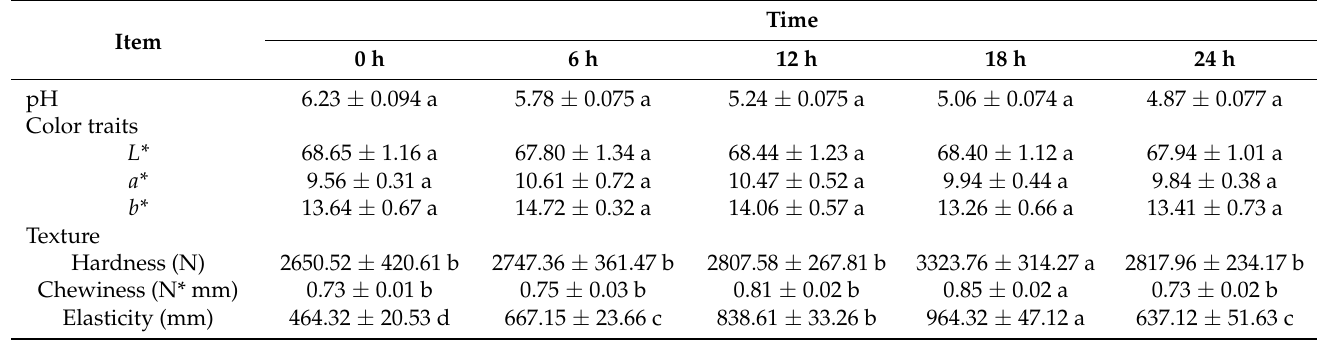
Table 4. pH, colour, and texture of fermented sausage at different time